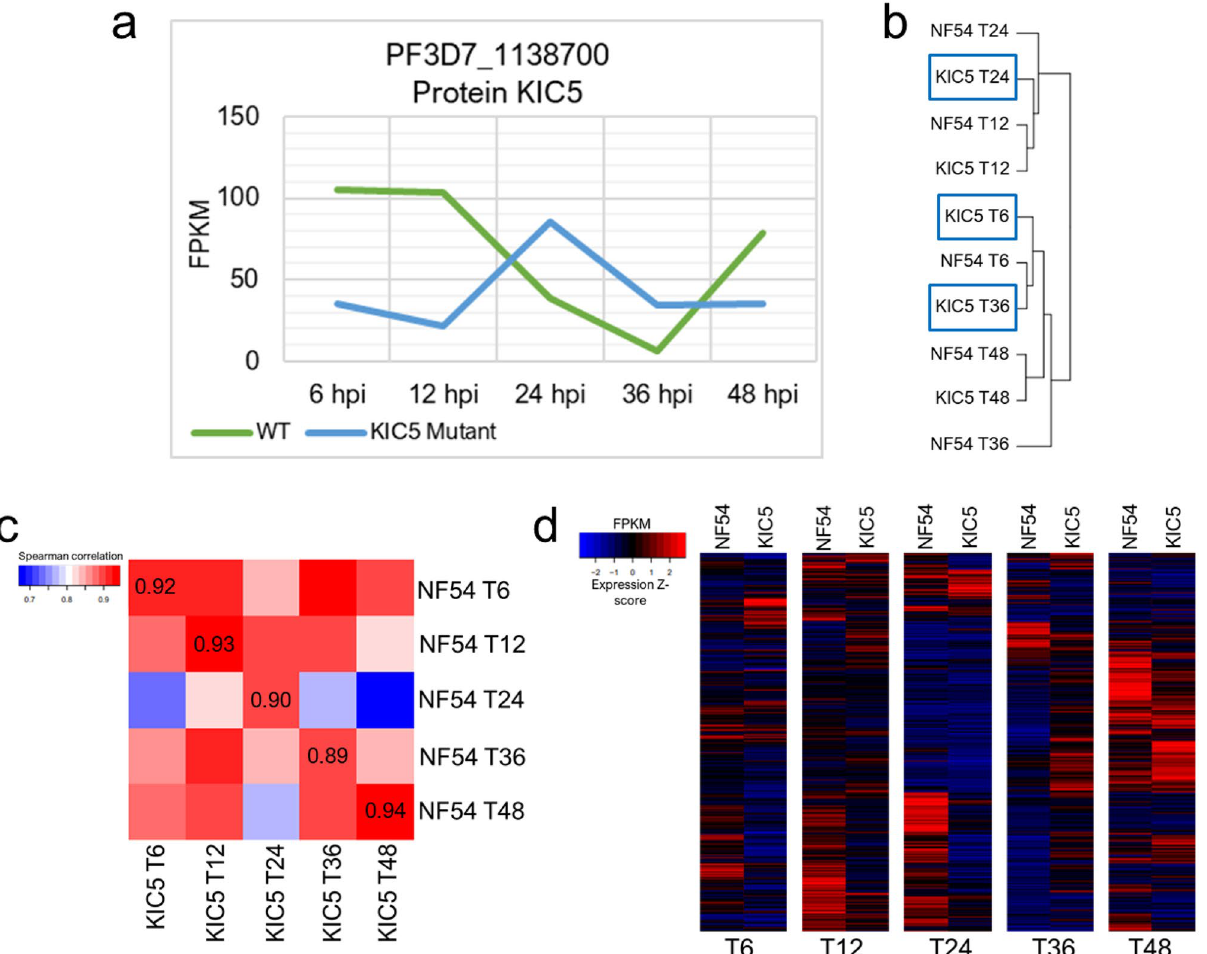
Figure 2. The KIC5 mutant has an altered transcriptome compared to the isogenic wild-type NF54. ( a ) Expression of the KIC5 gene across the 5 timepoints analyzed in this study show peak expression of the gene change from early ring in NF54 (green line) to early trophozoite stage in the mutant (blue line). Results are shown in fragments per kilobase per million mapped reads (FPKM) averaged across two bio-replicates (Supplementary Table S3). ( b ) Dendrogram of WT and KIC5 mutant timepoint expression correlations show alternate correlations of KIC5 6 hpi, 24 hpi, and 36 hpi. Dendrogram obtained via hierarchal clustering of NF54 and KIC5 mutant FPKM expression from heatmap.2 function in R Studio. ( c ) Spearman correlation heatmap of KIC5 mutant timepoints to NF54 timepoints (Spearman correlation values in Supplementary Table S5). ( d ) Heatmap comparison of gene expression in WT vs the KIC5 mutant across timepoints analyzed in this study show that gene expression is altered in the KIC5 mutant. Shown in Expression Z-score of gene FPKM values (Supplementary Table